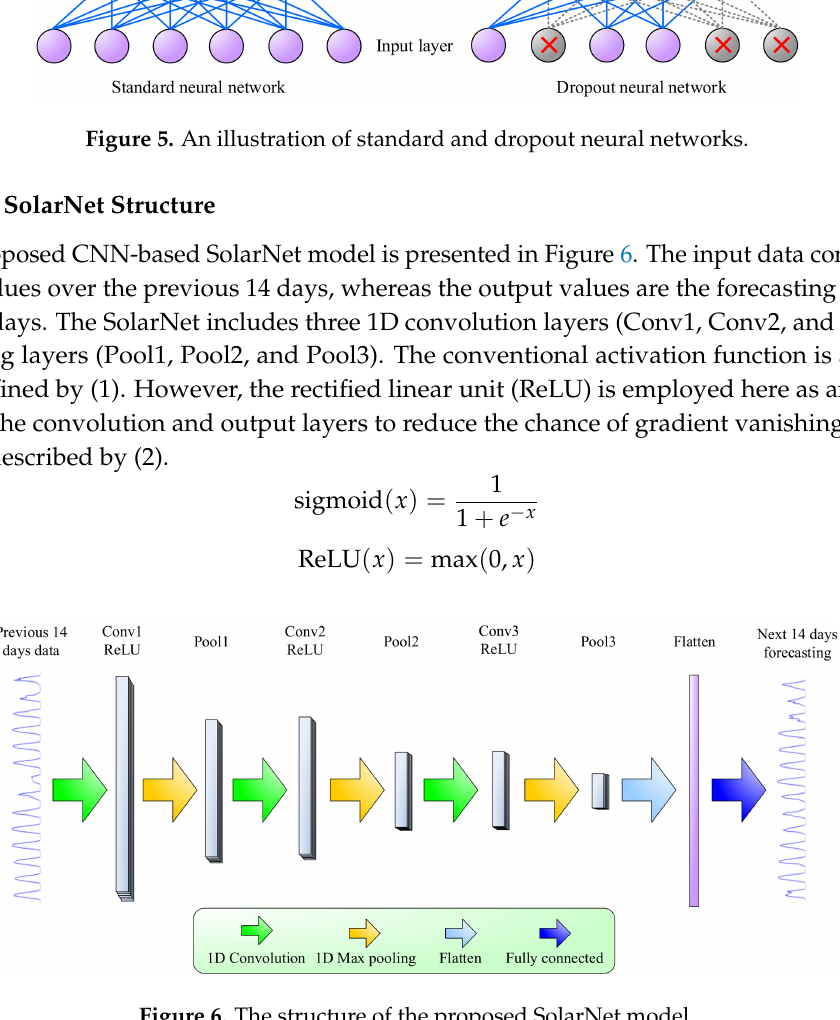
Figure 6. The structure of the proposed SolarNet